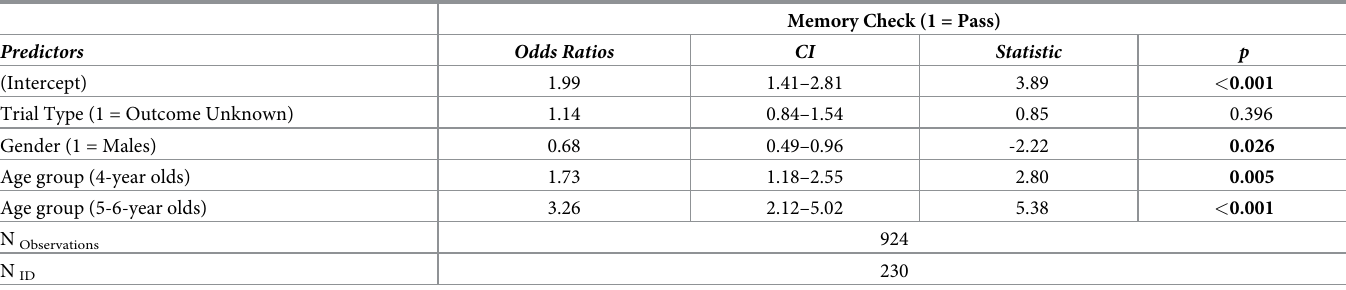
Table 2. Mixed effect logistic regression with a random intercept for subject examining the effect of trial type, gender and age group on memory